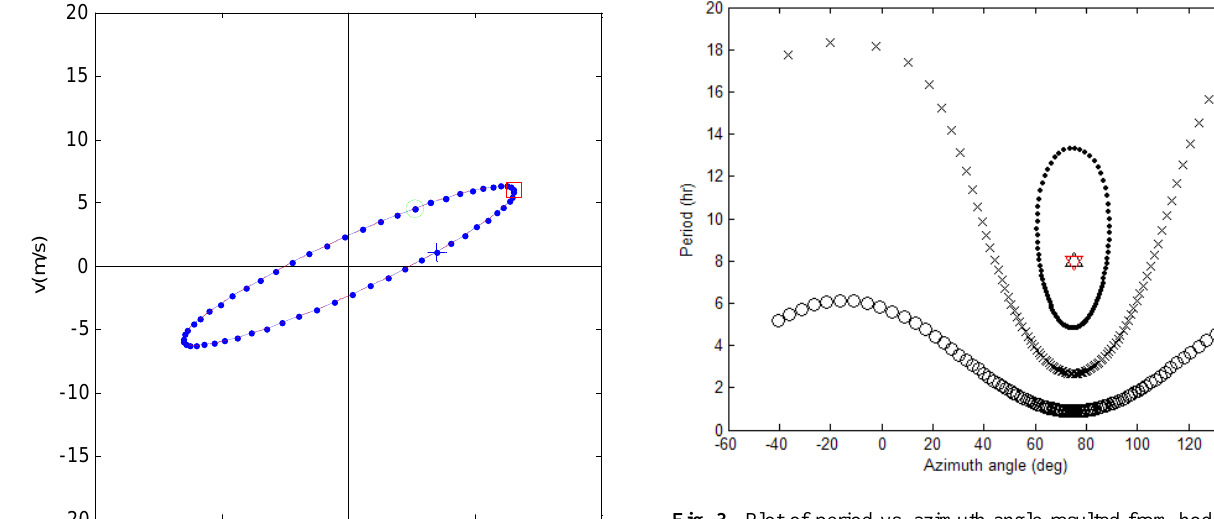
tained τ = 8 . 27 h, ϕ az = 73 . 2 ◦ and d = 0 . 97. The results 20